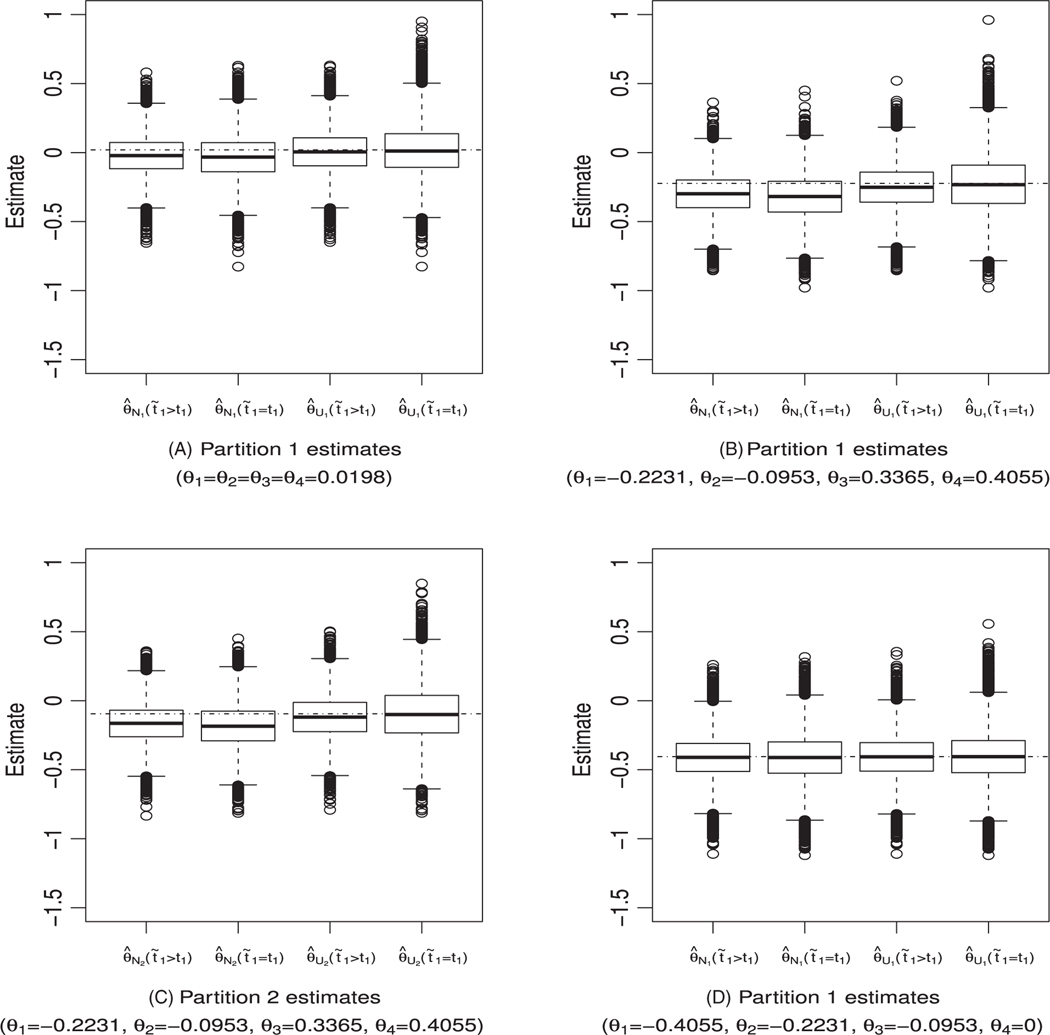
Boxplots for estimates in partition 1 (panels A, B, and D) and partition 2 (panel C) when the full population is selected to continue to stage 2 for Weibull distribution (γ = 0.5). The horizontal dashed and dotted line corresponds to the true log hazard ratio